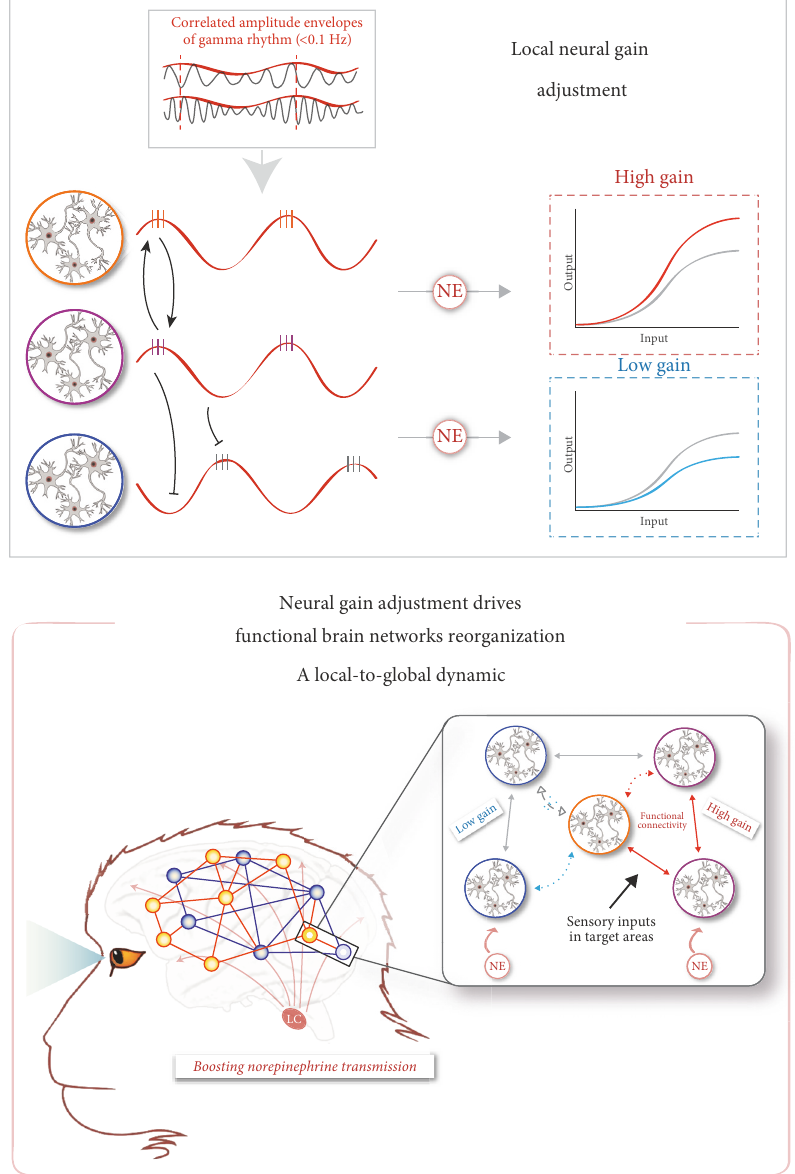
Figure 3: Mechanism proposed for the NE-dependent local-to-global neuronal dynamics — top panel — relationship between the amplitude envelope correlations in gamma rhythm and NE-dependent local neural gain adjustments. The orange and purple neuronal populations, whose amplitude envelopes co fl uctuate, allow the increase in neural gain induced by the norepinephrine system activation to be e ff ective and to spread (upper-right inset, red trace), whereas the purple and blue neuronal populations that exhibited a distinct temporal dynamic do not allow the increase in neural gain to be expressed locally, and this results in a decrease in neural gain (bottom-right inset, blue trace) — bottom panel — boosting norepinephrine transmission is thought to induce an increase in neural gain. The insert illustrates an example of the e ff ect of neural gain adjustment on interactions between di ff erent neuronal populations. The fi ve groups of neurons are anatomically interconnected. Sensory input signals in fl uence the activity of target regions (purple and orange groups of neurons). Norepinephrine transmission also modulates the activity of groups of target neurons (violet and blue groups of neurons), increasing or decreasing the neural gain, respectively. The ampli fi cation of gain in the neuronal violet group then induces an increase in the functional connectivity between violet and orange groups (red arrows). Similarly, the reduction in neural gain in the blue neuronal group induces a decrease in functional connectivity between blue and orange groups (blue arrow and cross). Thus, under the in fl uence of this local modulation of neural gain, neural networks recon fi gure, creating a new organization of functional networks at the whole-brain